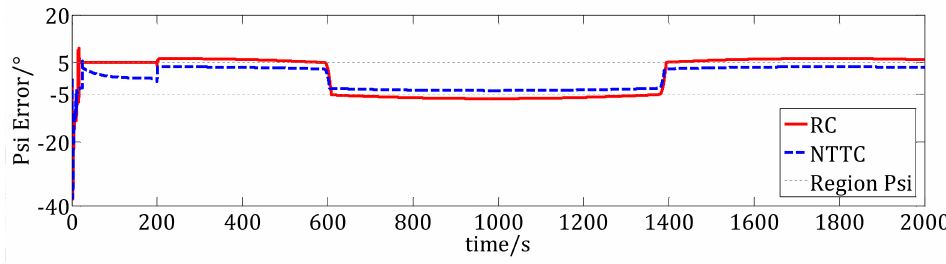
Figure 9. Yaw tracking